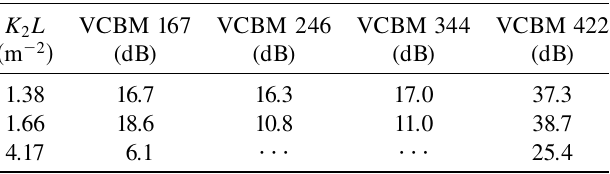
TABLE I. Amplitudes of vertical modes versus harmonic sextupole